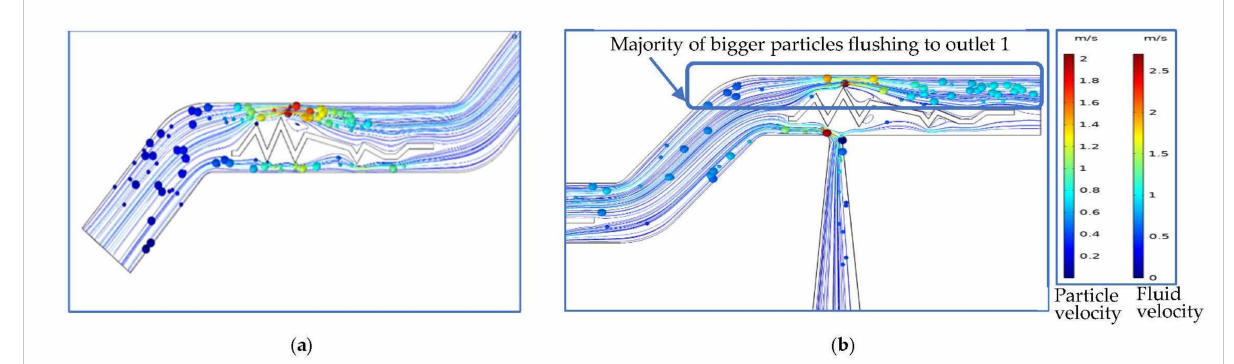
Figure 4. Corrugated dragonfly wing microchip’s streamlines and particle view; ( a ) Particle trajectory at the 1st dragonfly wing at time 0.004 s; ( b ) Particle trajectory at the 2nd dragonfly wing or the Outlet 1 at 0.0112